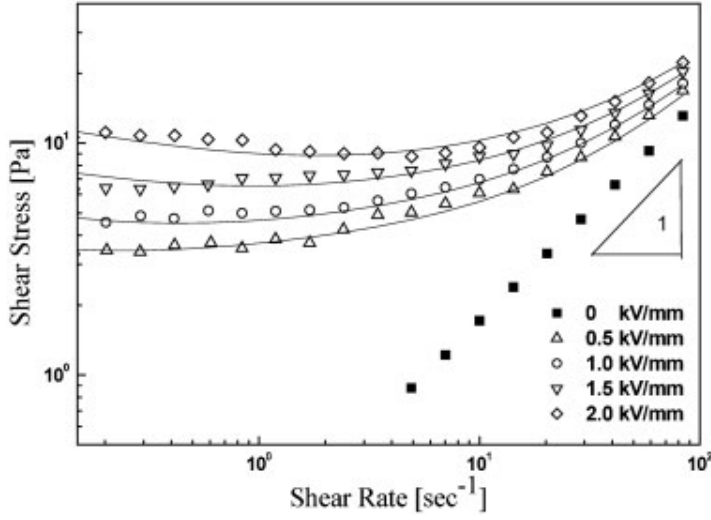
Figure 11. Shear stress vs. shear rate curve of MWNT/PMMA particle based ER fluid under various electric fields; the solid lines were obtained by CCJ model (reprinted with permission from [33], Copyright 2007